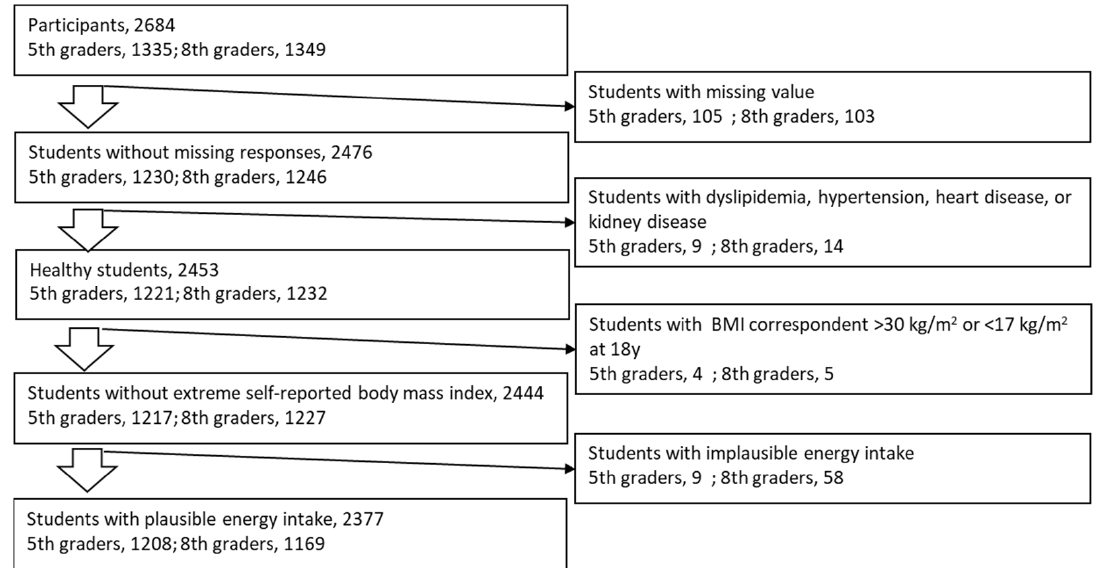
Figure 1. Subject selection.